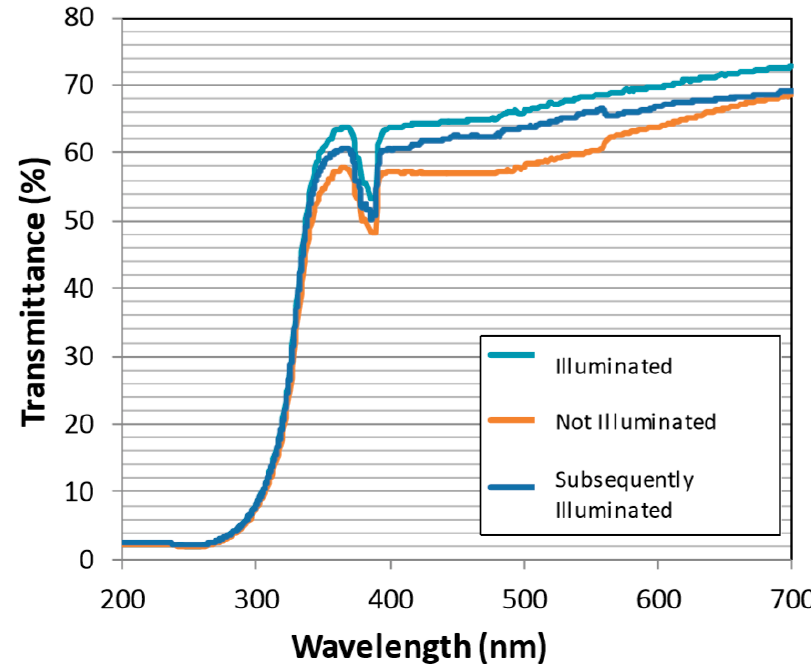
Figure 5. Spectral transmission of the photo-active coating after submergence in a bio-active environment. The ‘Illuminated’ sample was exposed constantly for 45 h (turquoise). The ‘Not Illuminated’ sample was in submergence for 45 h (orange), before being ‘Subsequently Illuminated’ for 45 h (blue).